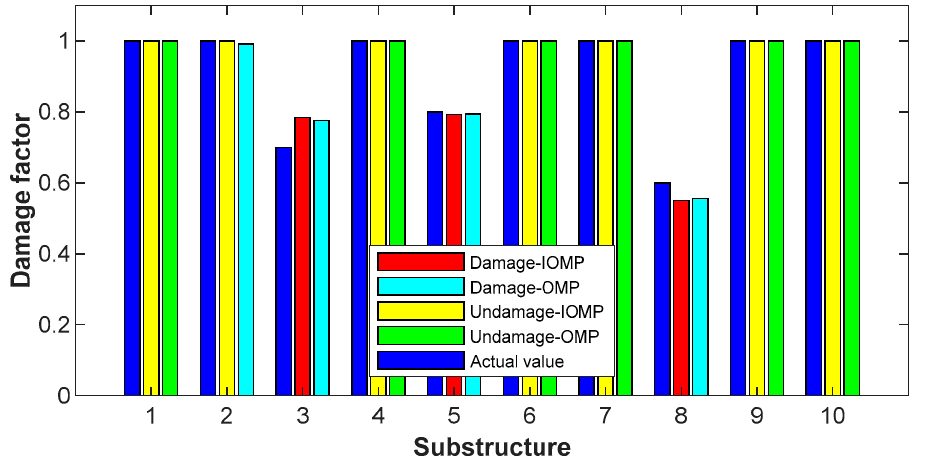
Figure 5. Identification results obtained using OMP and IOMP method (residual variance criterion).